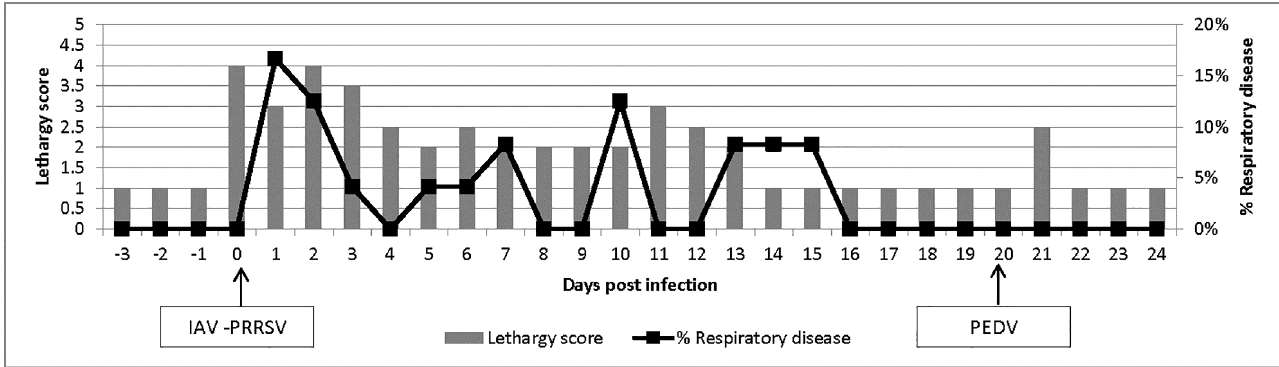
Fig 1. Clinical scores. Clinical scores of lethargy (1 to 5 scale) and percentage of respiratory disease (number of pigs with coughing and/or sneezing episodes) throughout the study.